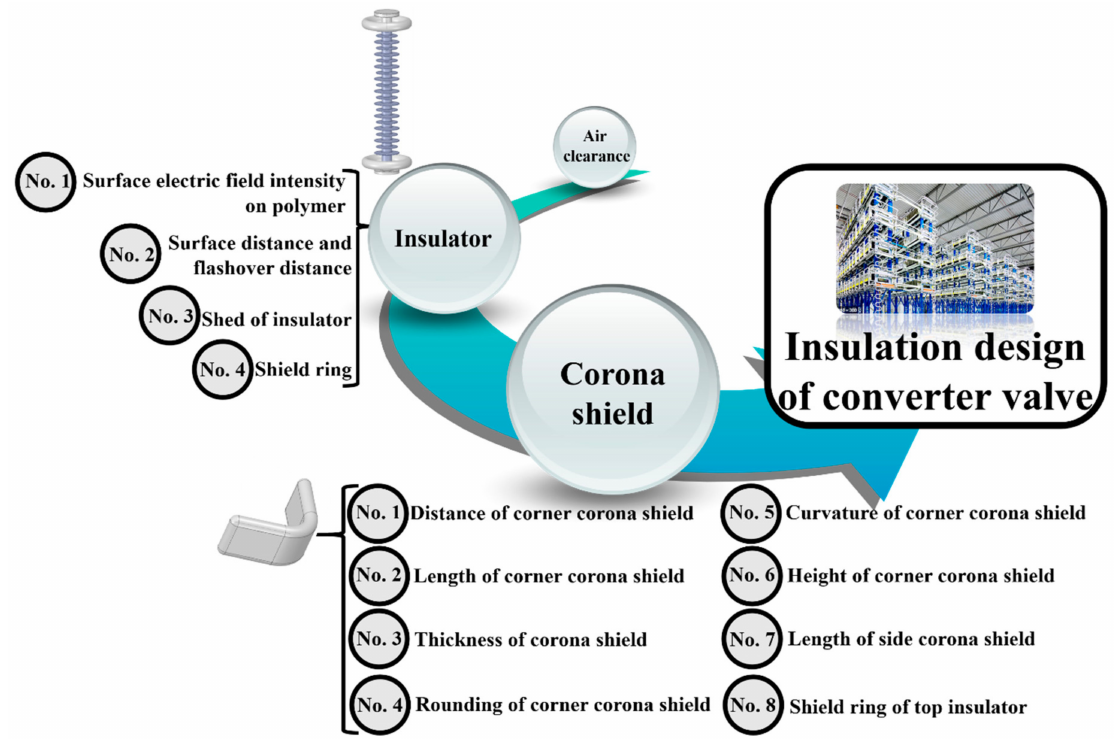
Figure 16. Design factors applied to the insulation design of a converter valve